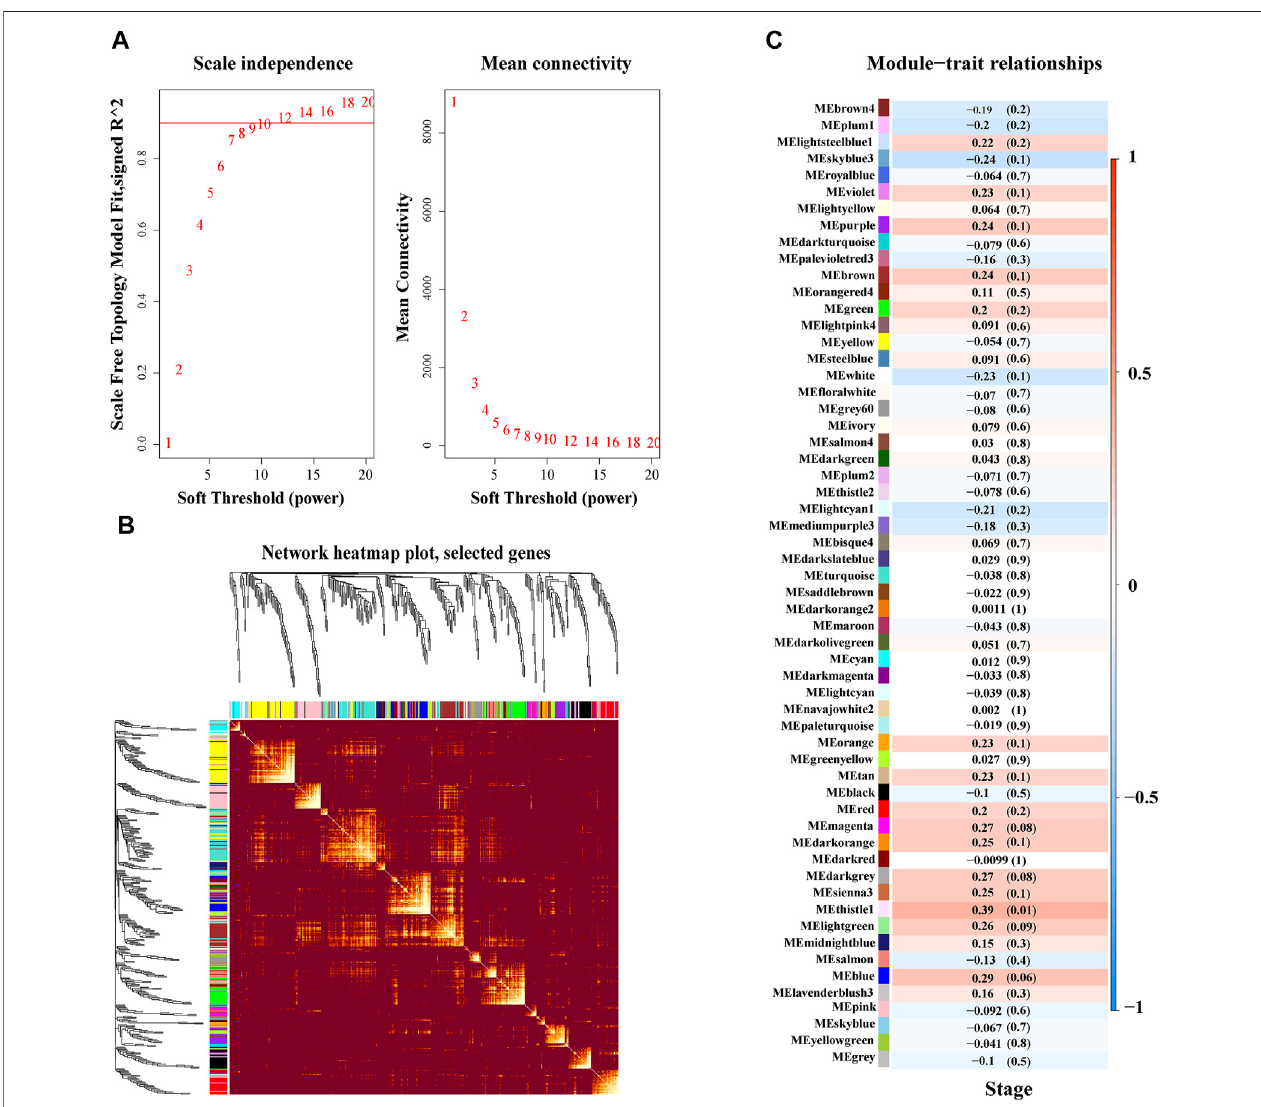
FIGURE 3 | Weighted co-expression and key module identi fi cation associated with clinical DLBCL stage. (A) Determination of soft threshold in WGCNA. (B) TopologicaloverlappingWGCNAheatmap. (C) Therelationshipbetweenmodulesandclinicaltraits.Pearsoncorrelationcoef fi cientwasusedtocalculatethecorrelation degree between each module and